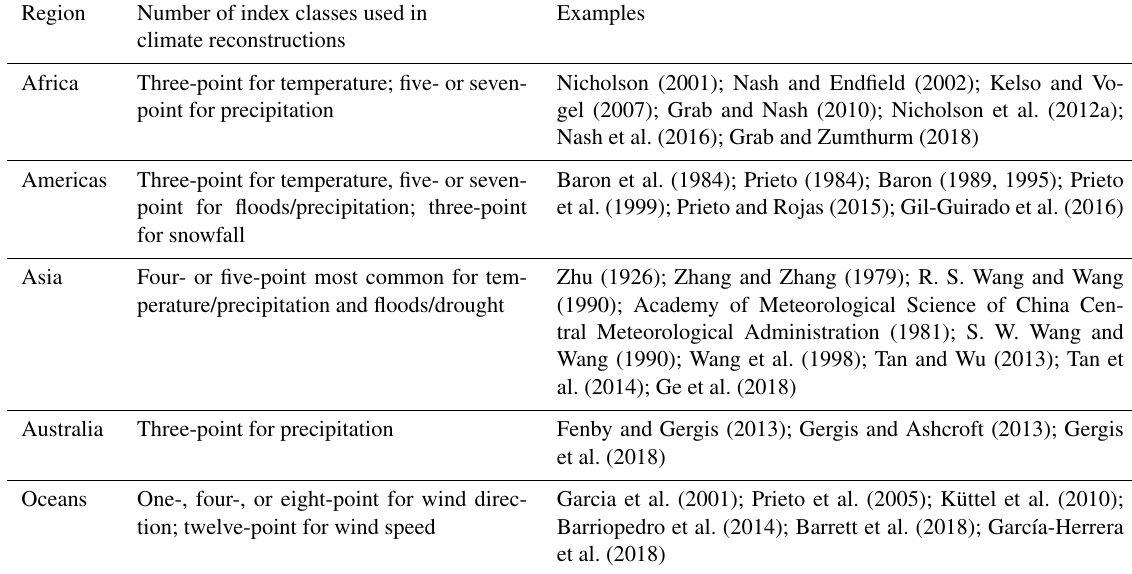
Table 7. Variability in the number of index classes used in index-based historical climate reconstructions in Africa, the Americas, Asia, Australia, and over the